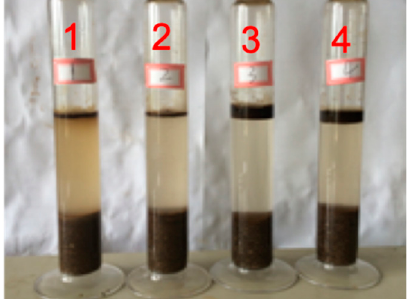
Figure 10. Efficiency of washing heavy crude oil before and after ageing for 3 d at 140 °C. ( 1 ) Petroleum sulfonates before ageing, ( 2 ) petroleum sulfonates after ageing, ( 3 ) SDY-1 before ageing and ( 4 ) SDY-1 after ageing. Table 2. Efficiency of washing oil before and after ageing for 3 d at 140 °C.